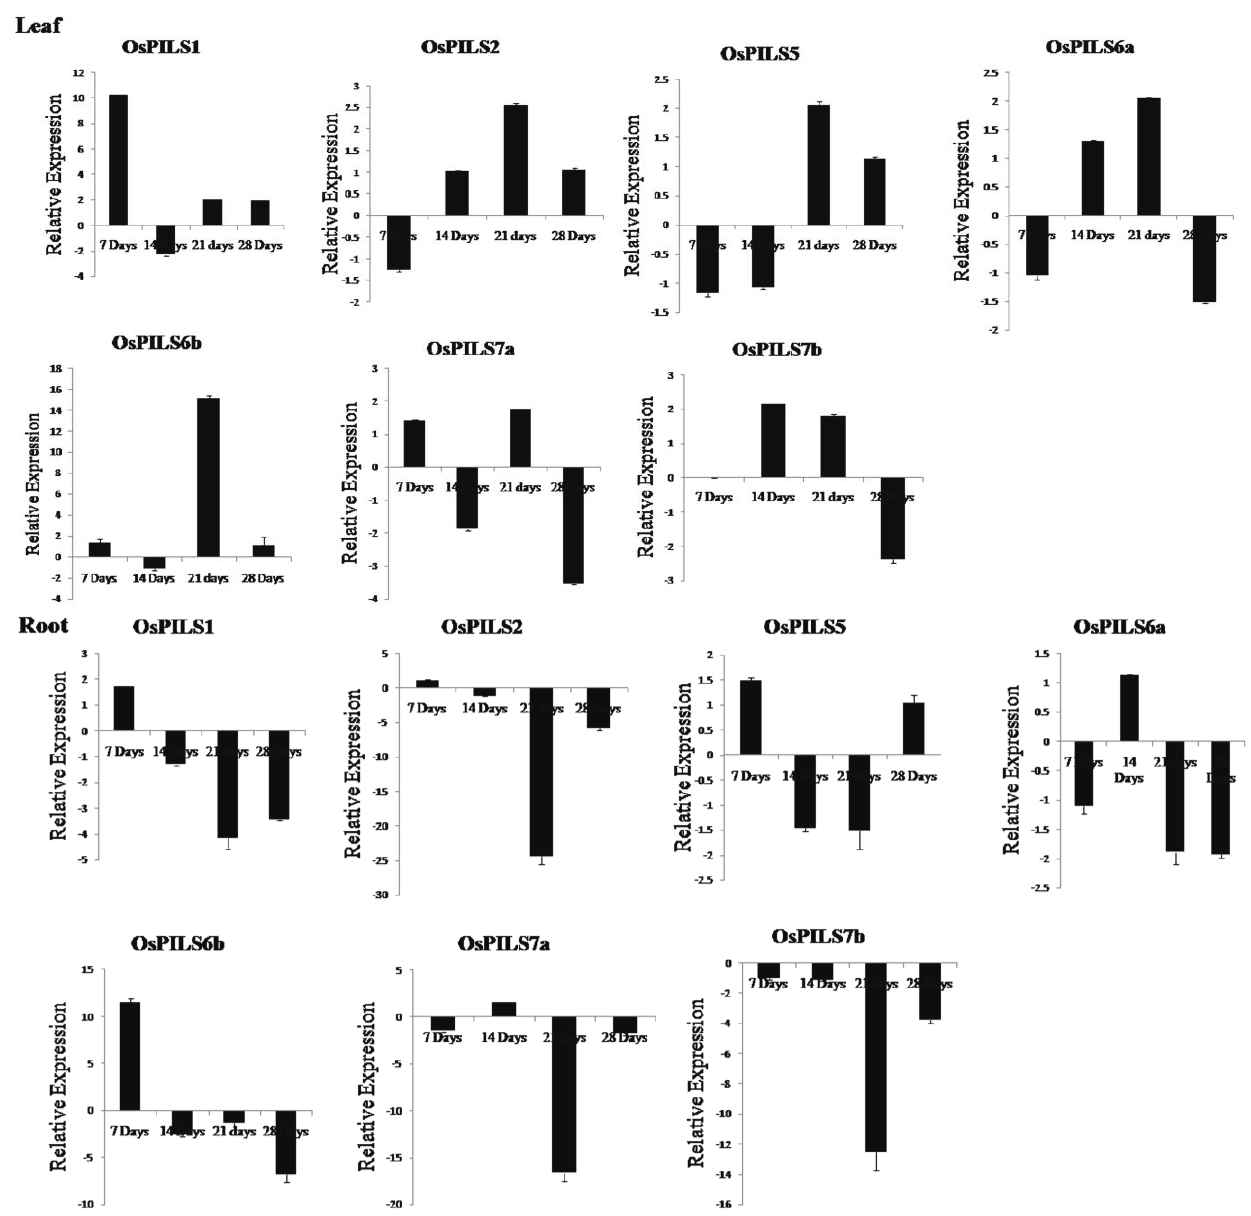
Figure 7. Relative expression of OsPILS genes in leaf and root tissues treated with 5 µM IAA (indole-3-acetic acid). The relative gene expression of OsPILS genes shows that all OsPILS genes were up-regulated in auxin treated leaf tissues and down-regulated in auxin treated root tissues at 21